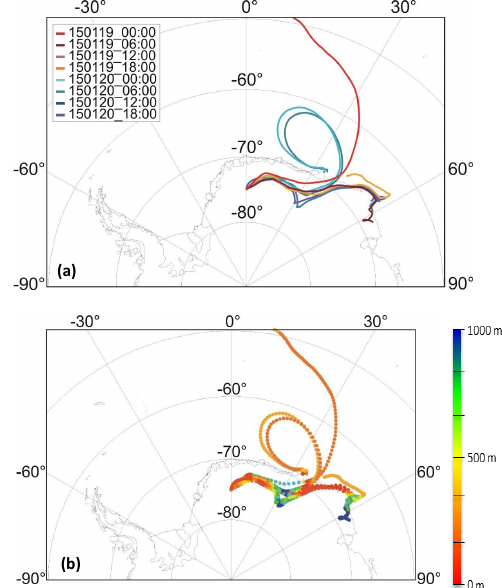
Figure 14. The 5-day backward trajectories during the NPF event calculated with a trajectory starting height of 100m above Kohnen at the points in time given in the legend (a) . Below, the travel height above the ground (local topography) is illustrated in a color-coded scale (point interval 1h) (b)